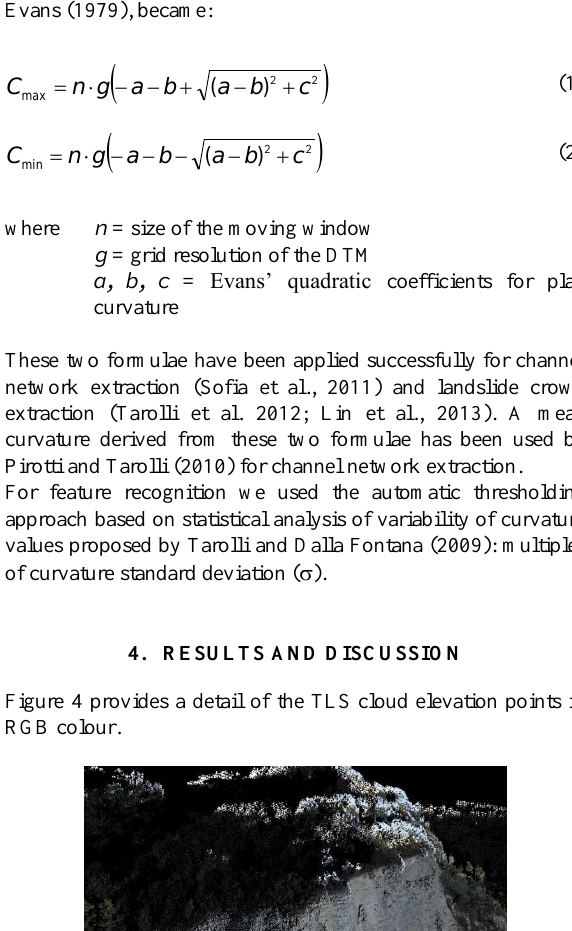
Figure 5. Shaded relief map obtained from 0.1 m DTM. The red box indicates the likely unstable area shown in detail in Figure 3.